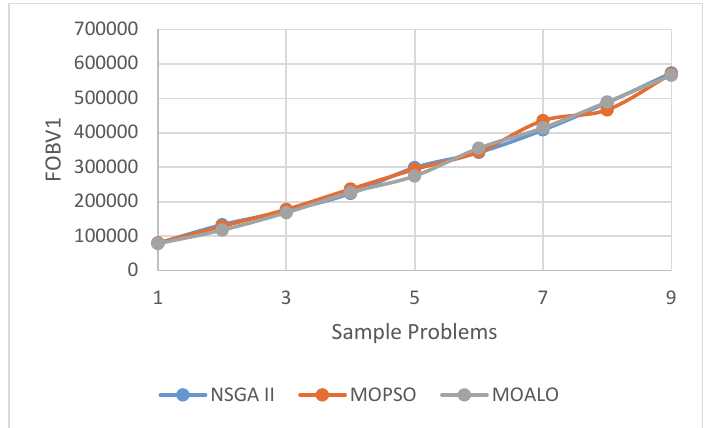
Fig. 16 . Changes in averages of the first objective function in large sample sizes